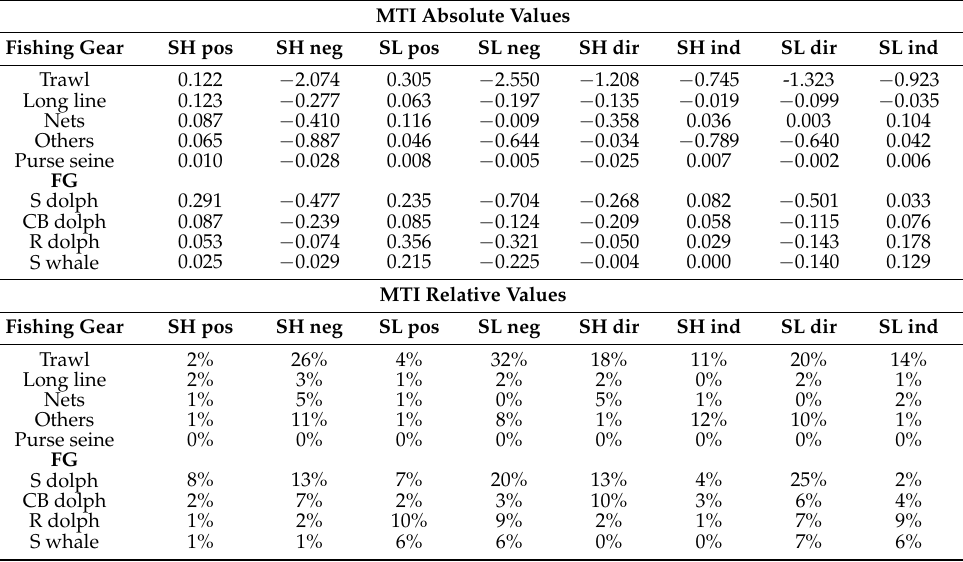
Table A3. Mixed Trophic Impact (MTI) of the odontocetes and the types of fishing gear exerted on the shelf (SH) and slope (SL) domains. The impacts were divided between positive (pos) and negative (neg) and between direct (dir) and indirect (ind).